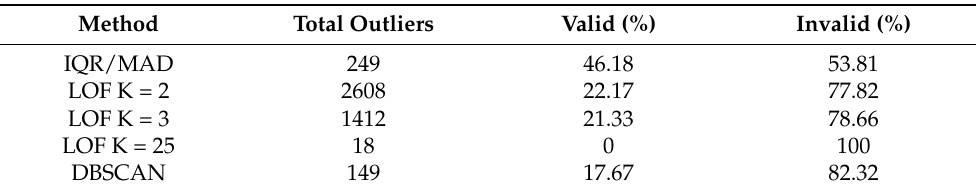
Table 3. Number of valid/invalid outliers detected using the implemented scoring method for Faculty of Electrical Engineering location.